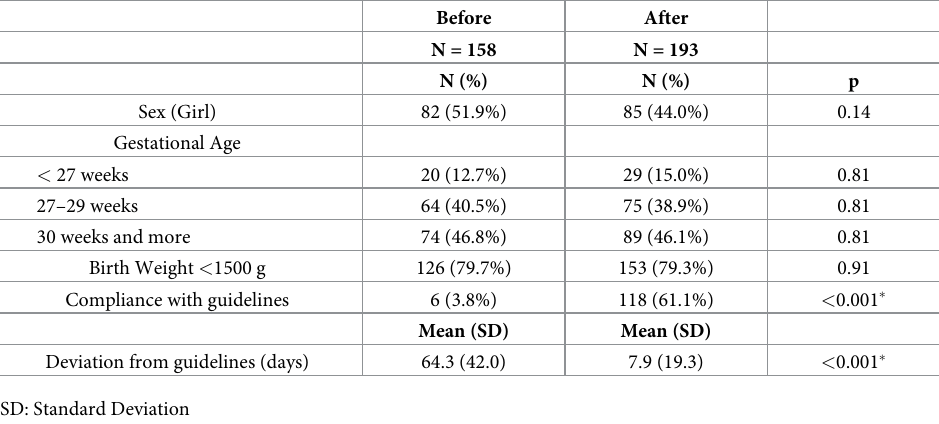
Table 2. Infants characteristics and outcomes for effectiveness—CHSF medical center, before and after periods.